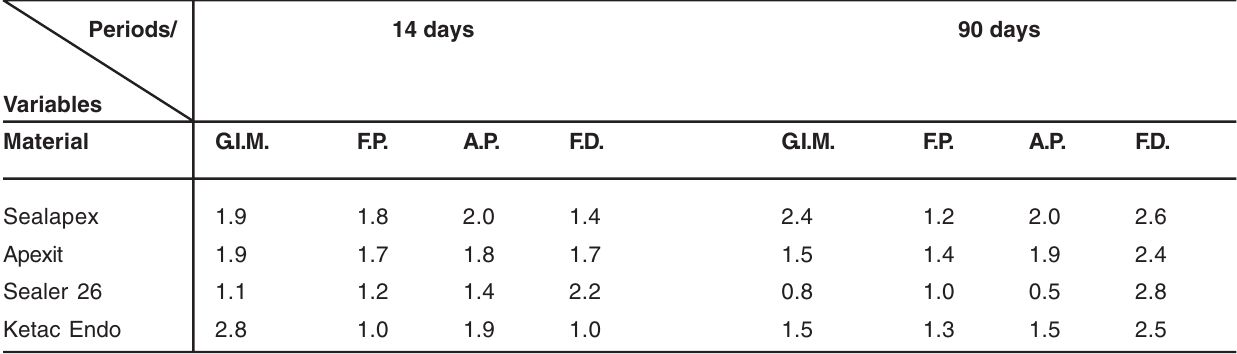
TABLE 1- Means of the variables general inflammation magnitude (G.I.M.), Fibroblastic proliferation (F.P.), Angioblastic proliferation (A.P.), and Fibrosis density